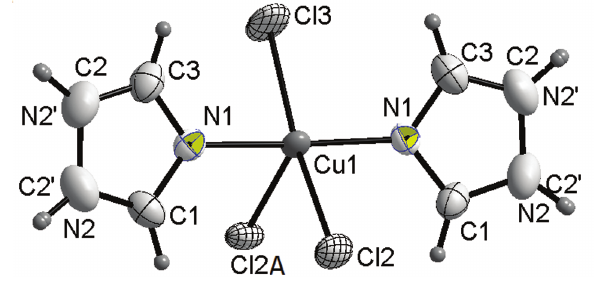
Table 1: Data collection and handling.